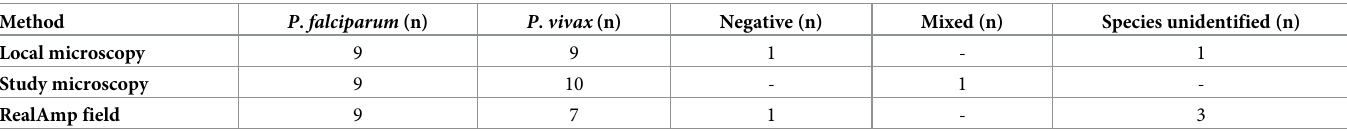
Table 2. Results of different tests for malaria in samples confirmed to have mixed infections in Cruzeiro do Sul, Acre state (n = 20).